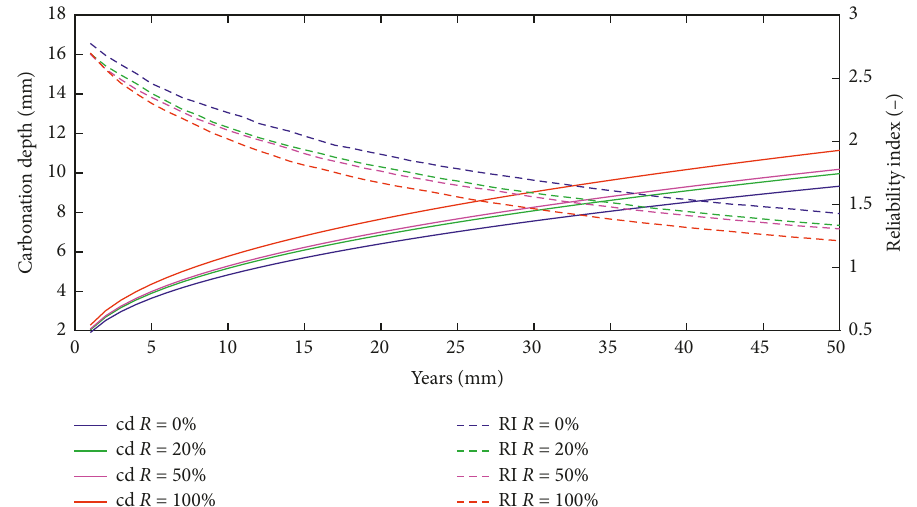
Figure 3: Carbonation depth (continuous line) and reliability index (dashed line) versus service life-XC3 exposure class: w/c � 0.55.